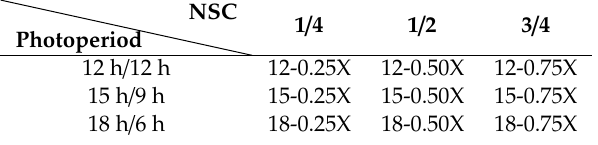
Table 1. Nine treatments of photoperiod combined with nutrient solution